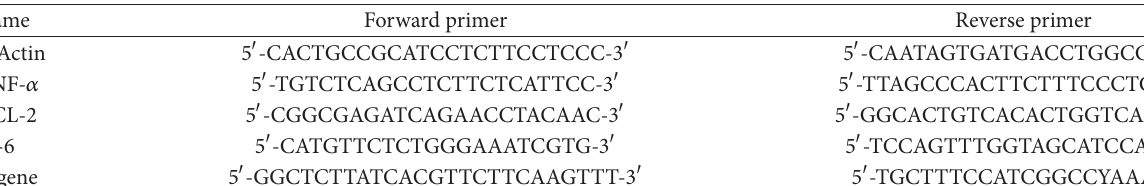
Table 1: Primers sequences used in qPCR.